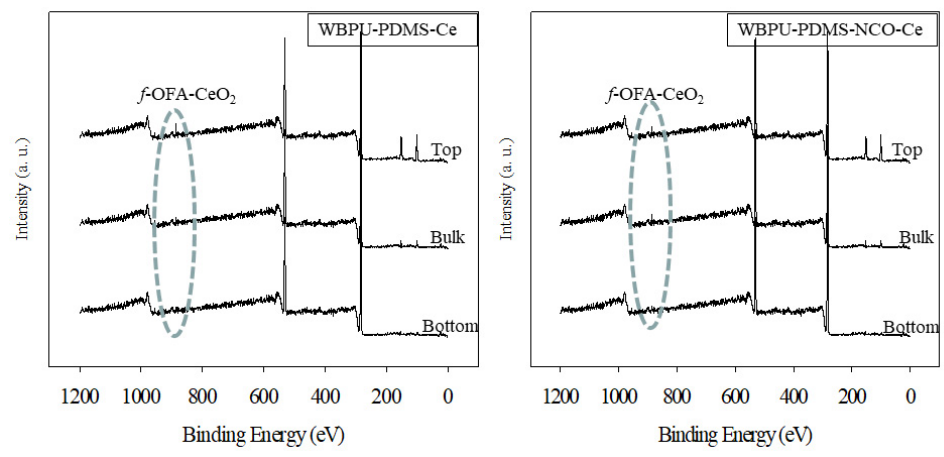
Figure 4. XPS scan of WBPU-PDMS-Ce and WBPU-PDMD-NCO-Ce films.